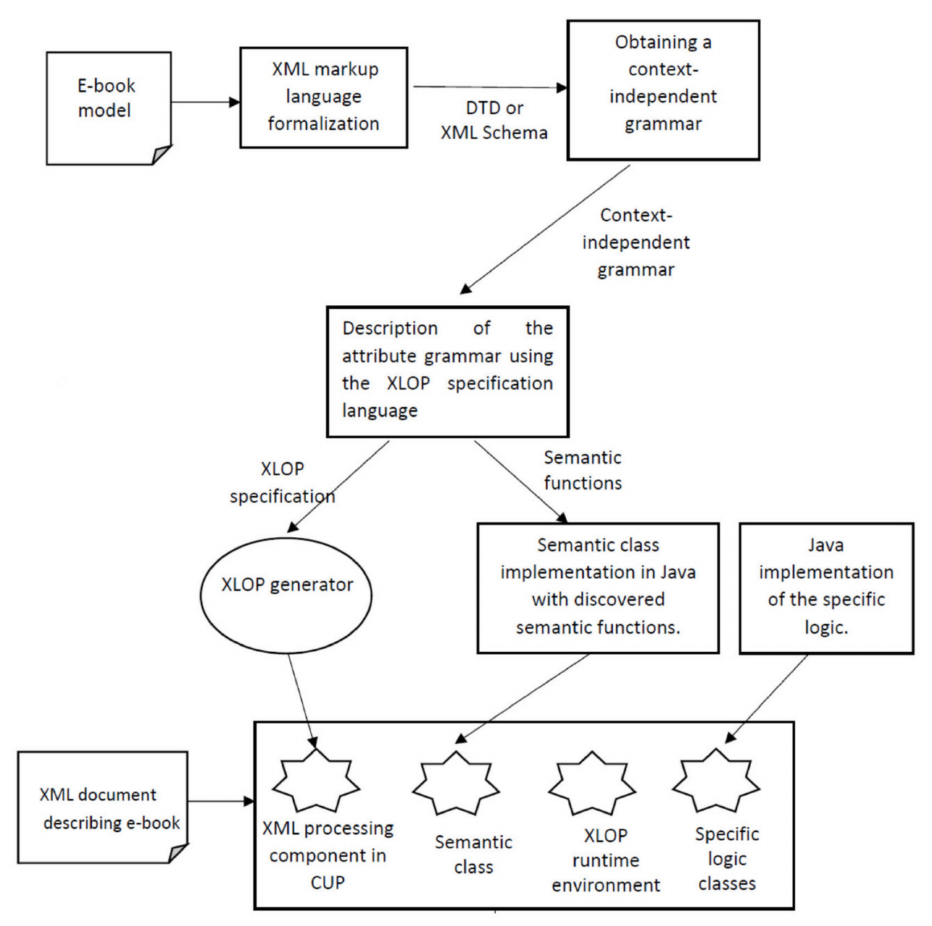
Figure 3. Electronic book production cycle.